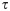
Estimation of the threshold τ for the inference of CMN.Panel (a) is the plot of MIR¯XY before ordering its values in ascending order, and (b) after ordering them in ascending order. Following the approach in the text, τ ≈ 0.21 plotted by the red dash line in both panels.